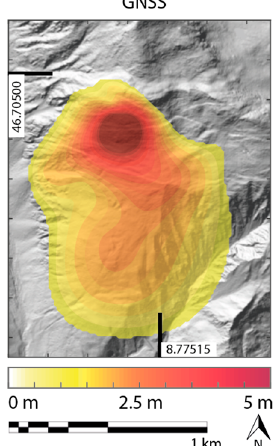
Figure 4. Interpolation of the CdV displacement field based on the 23 GNSS measurements only. Blank areas indicate portions of the slope without information or with deformations below DIC accuracy. WGS 84. (Hillshade taken from [40]).